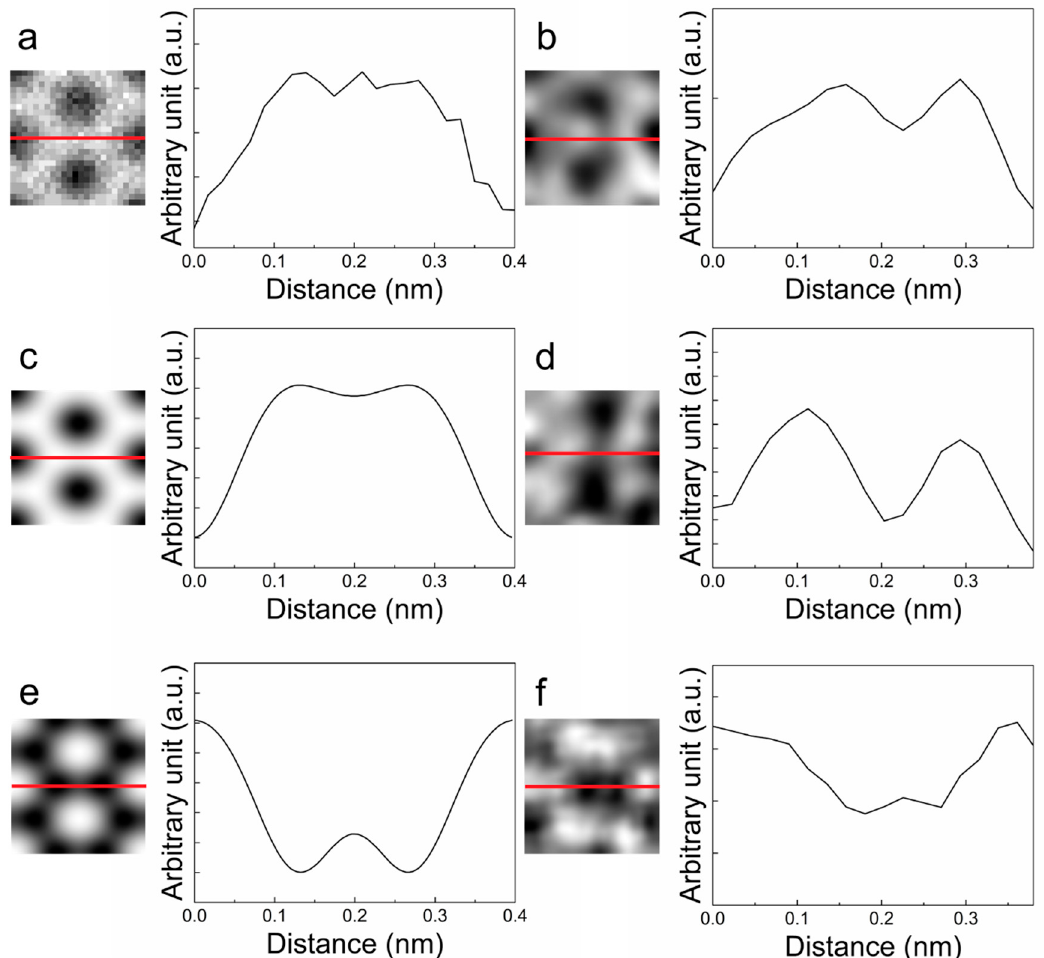
Figure 2. Images and intensity profiles of the simulated ( a,c,e ) and experimental ( b,d,f ) data by the CDDAE framework. The intensity profiles are plotted along the solid red lines from left to right in each image. ( a ) Image simulation result; ( b ) Input image; ( c ) Amplitude of simulated exit wave; ( d ) Amplitude of reconstructed exit wave; ( e ) Phase of simulated exit wave; ( f ) Phase of reconstructed exit wave.